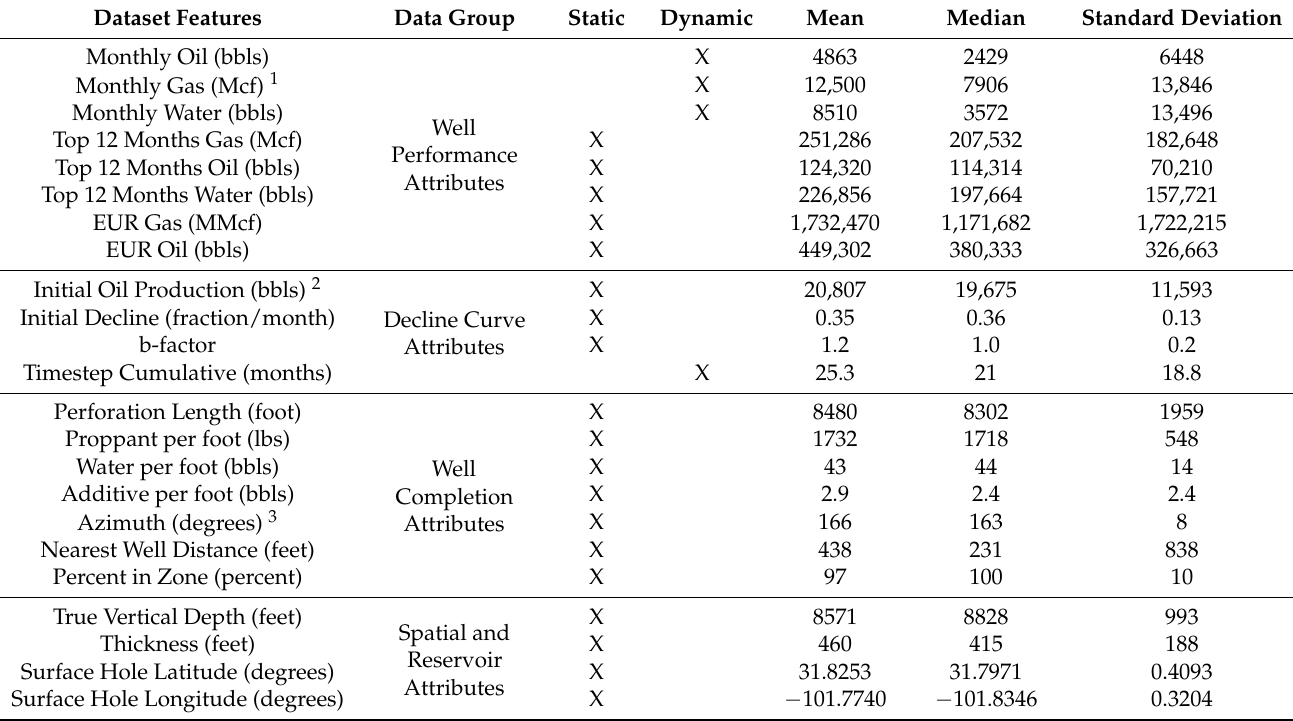
Table 2. Statistical summary of the study dataset features